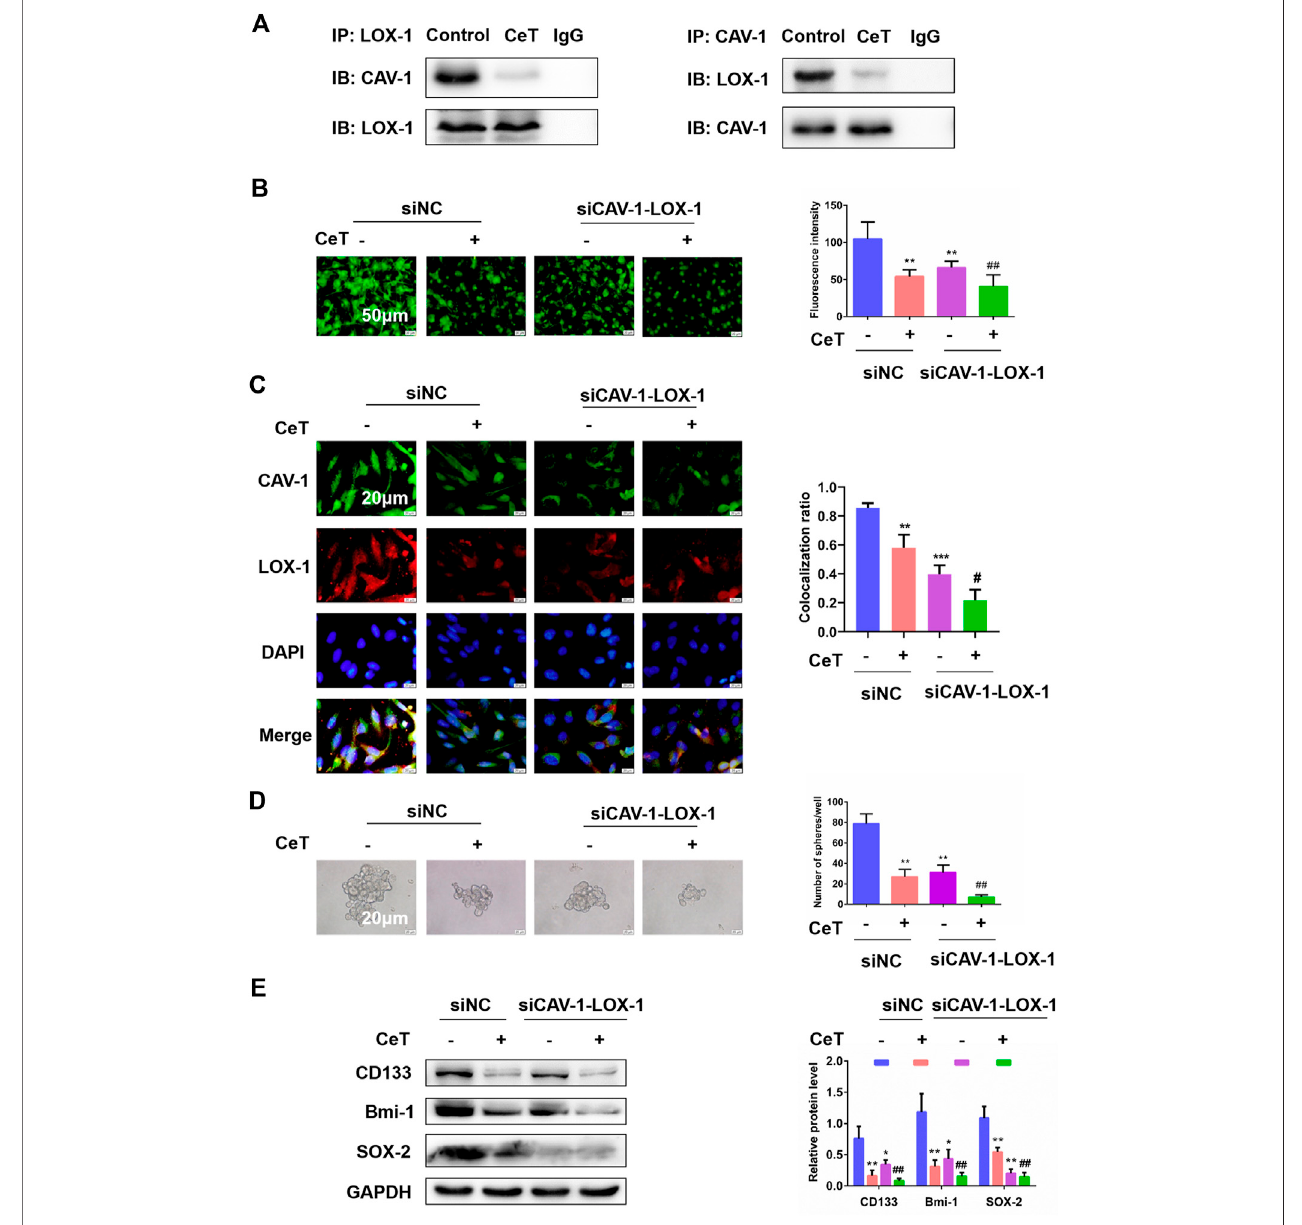
FIGURE 6 | Celastrol attenuated lipid accumulation and stemness by inhibiting the binding of CAV-1 and LOX-1 (A) The speci fi c interaction between CAV-1 and LOX-1 in untreated or CeT-treated 786-O cells was detected by co-immunoprecipitation test (B) BODIPY staining showed intracellular lipid levels. Scale bar: 50 µm (C) Co-localization of CAV-1 and LOX-1, as visualized at the subcellular level by double immuno fl uorescence staining. Scale bar: 20 µm. The Pearson ’ s correlation was shown in bar graph from three independent experiments (D) Self-renewal ability in siCAV-1-LOX-1 786-O cells was detected by sphere formation assays. Scale bar: 20 µm (E) Western blotting of stemness-associated markers, including CD133, Bmi-1 and SOX-2. * p < 0.05, ** p < 0.01, *** p < 0.001 vs. the control group; # p < 0.05, ## p < 0.01 vs. the siCAV-1-LOX-1 cells.